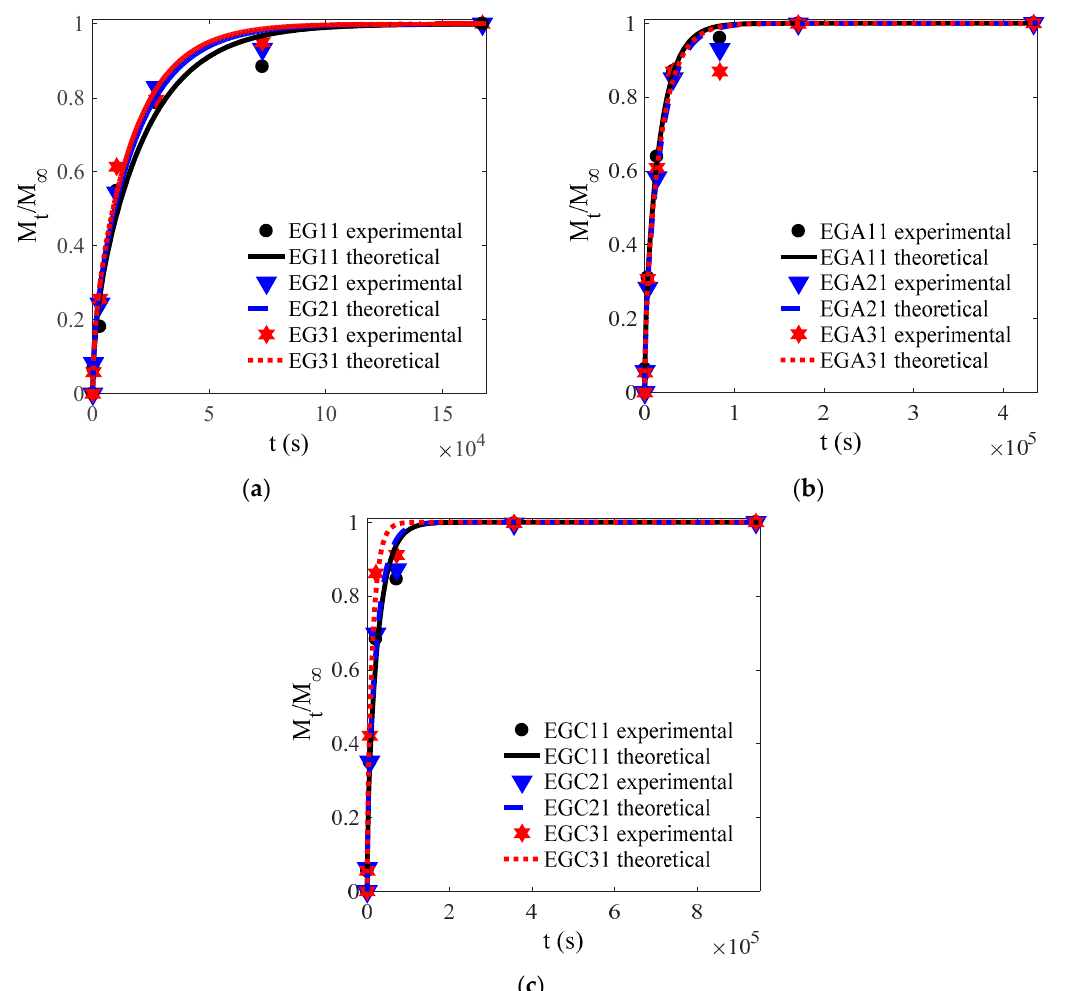
Figure 5. Experimental and theoretical values of one-way release tests of CEOs released from films EG ( a ), EGA ( b ), EGC ( c ) to water at 4 °C.